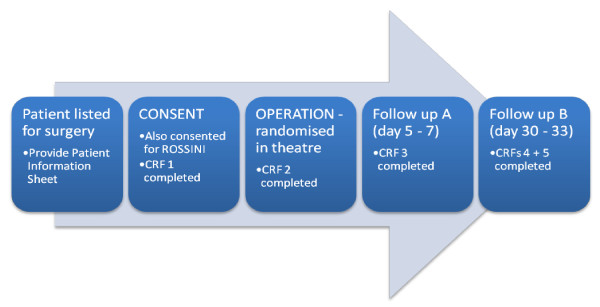
Flowchart Illustrating Study Process.